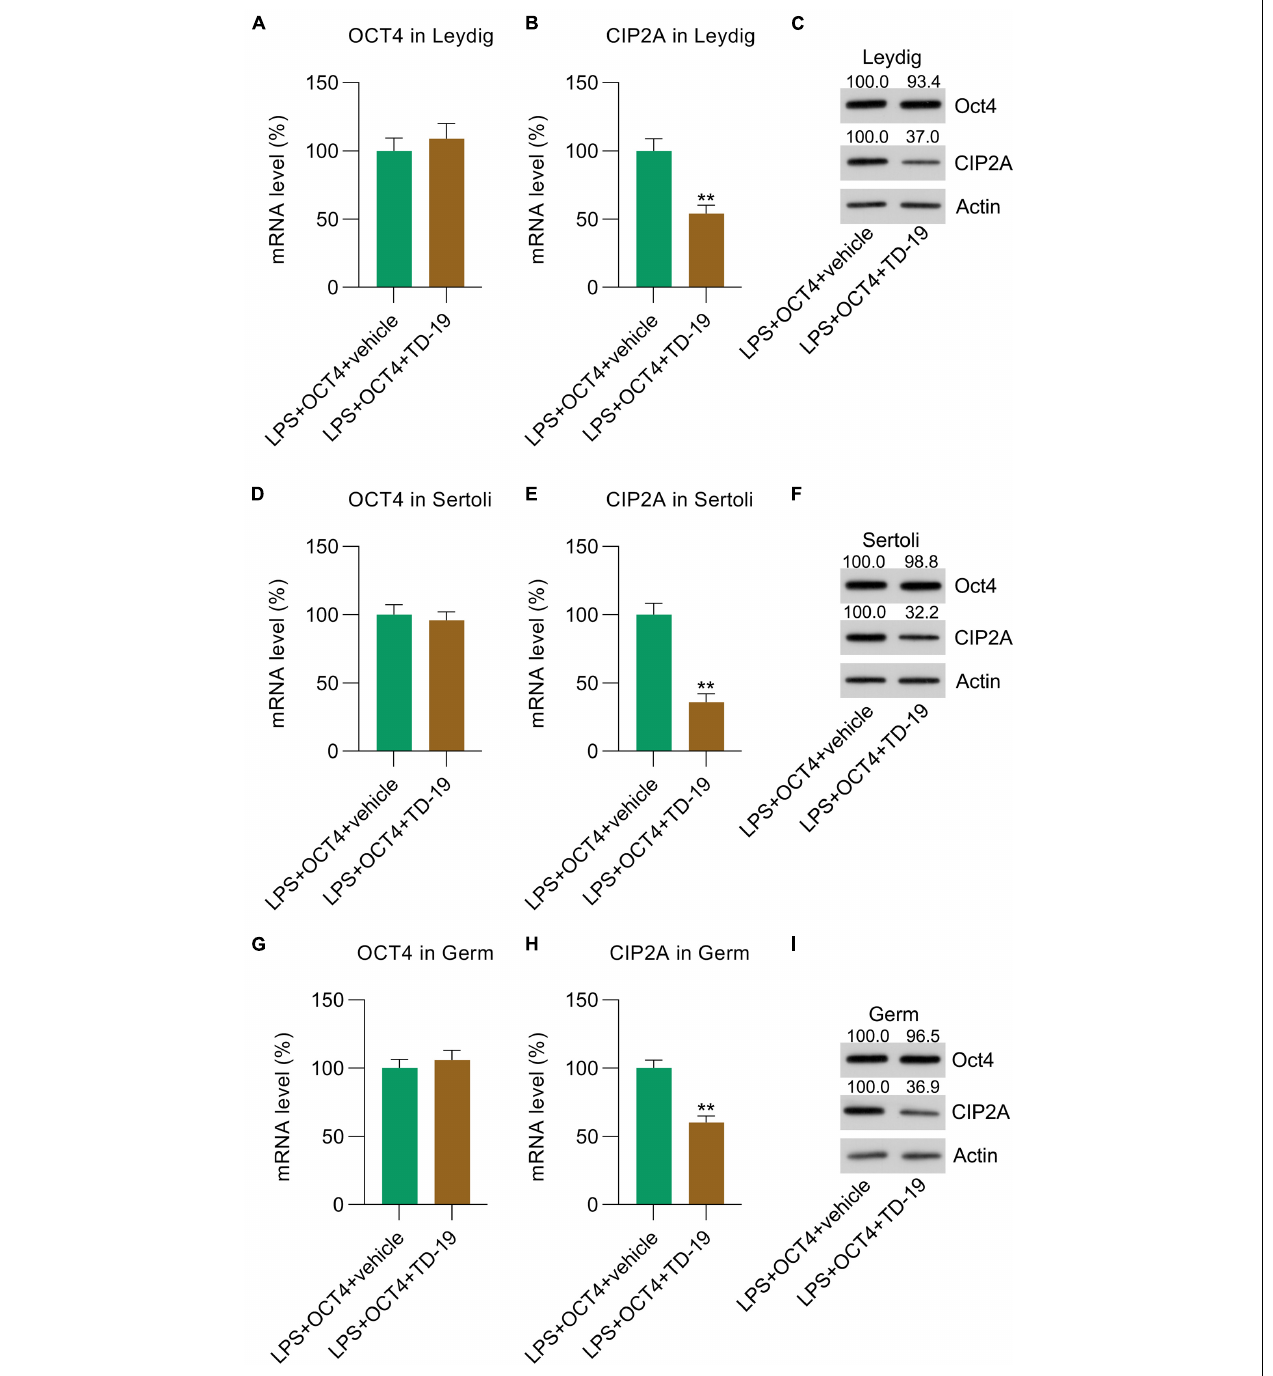
FIGURE 5 | TD-19 administration in OCT4-overexpressing and LPS-induced Sertoli, Leydig, and germ cells. Leydig, Sertoli, and germ cells were transfected with pcDNA3-OCT4 or pcDNA3-NC and then incubated with LPS and TD-19 for 12 h. (A,B,D,E,G,H) RT-qPCR showed the mRNA expression and (C,F,I) WB revealed the protein expression of OCT4 and CIP2A in the cells. Data are expressed as the means ± SDs. ** P < 0.01, LPS + OCT4 + vehicle vs. LPS + OCT4 +